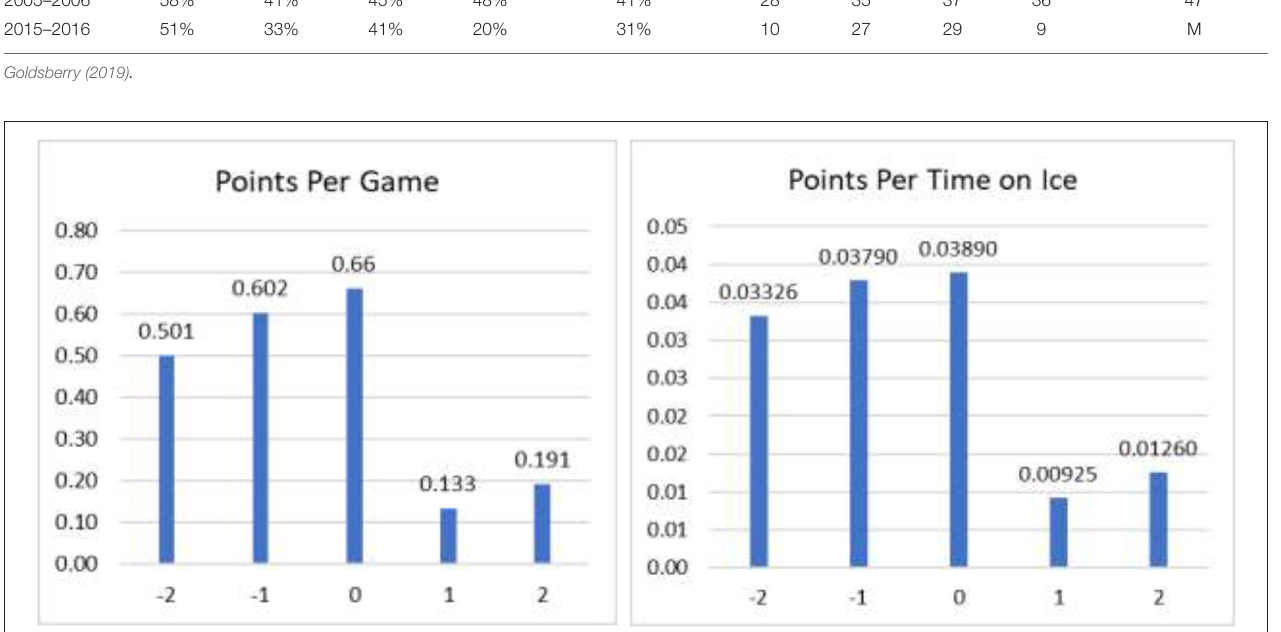
∗ Points Per TOI (PPTOI): (Total goals plus assists) divided by Time on the ice (TOI) in